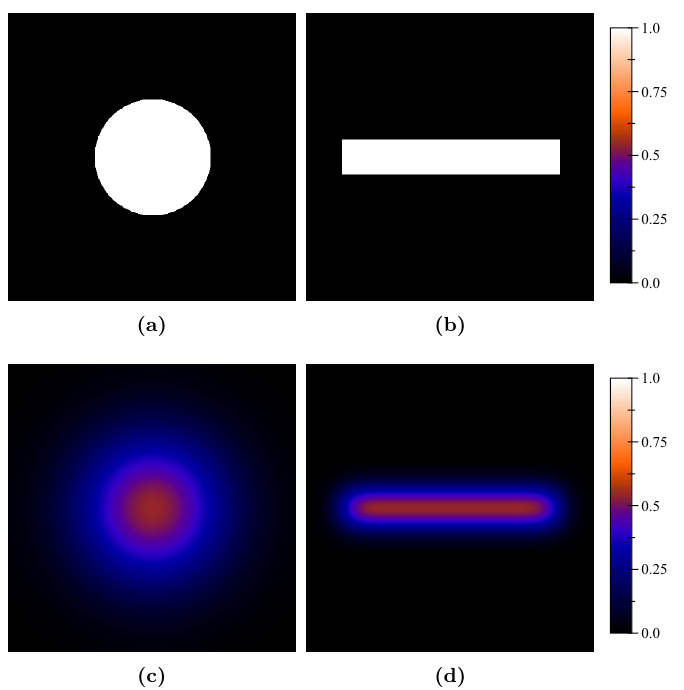
Figure A1. Results of the numerical convolution of the carotid model with the scanner PSF. Modeled petrous segment of the internal carotid artery filled with unit activity concentration in transverse ( a ) and axial ( b ) planes and corresponding simulated activity concentration after convolution with the scanner PSF modeled by an isotropic Gaussian kernel with standard deviation σ = 1.9 mm ( c , d ).